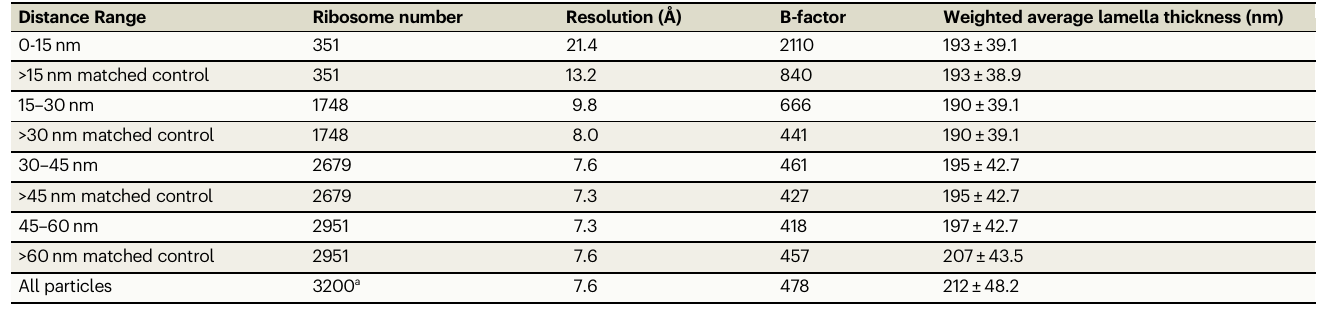
Table 4 | Effect of particle to milling surface distance on sub-volume averaging resolution Distance